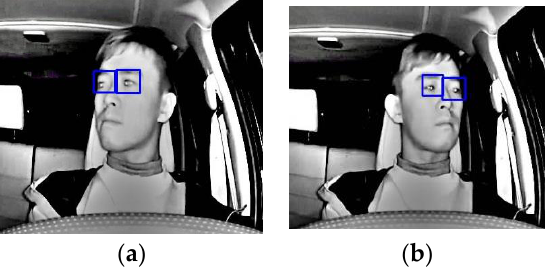
Figure 7. Determining the angle-of-focus: ( a ) focus to the right of driver ( b ) focus to the left.